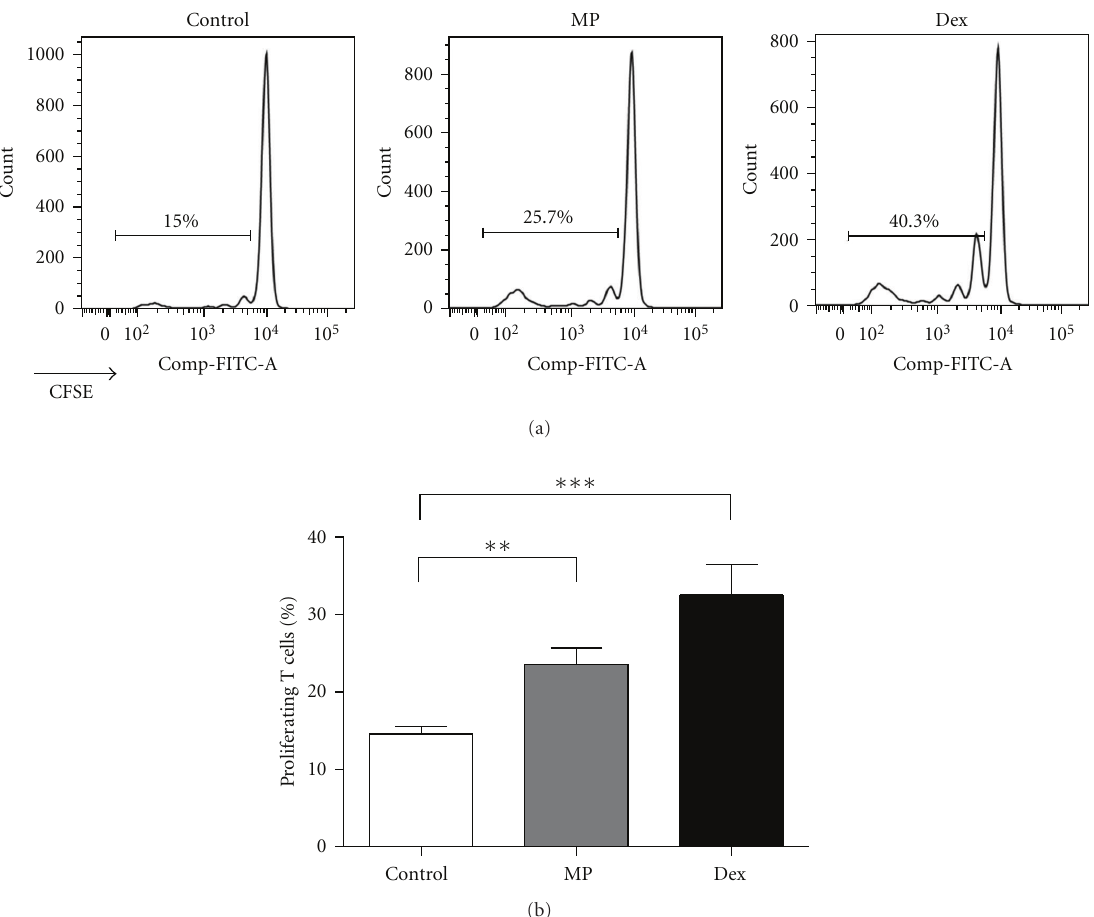
Figure 4: Homeostatic proliferation of transferred T cells after MP administration. C57Bl/6 mice were immunized with MOG 35-55 peptide and treated with 100 mg/kg MP, 100 mg/kg Dex, or PBS as a control on days − 1, 0, and 1. One day after the last treatment, 1 × 10 7 purified CFSE-labeled T cells from RFP expressing mice were adoptively transferred, and ten days later, spleens and lymph nodes were analyzed by flow cytometry. (a) Representative histograms of lymph node total RFP + T cells from PBS-(left), MP-(middle) or Dex-(right) treated mice are shown. (b) A quantification of the percentages of proliferating transferred T cells in the inguinal lymph nodes is depicted. n = 3-8 for each group. Statistical analysis was performed using the unpaired t -test ( ∗∗ P < 0 . 01, ∗∗∗ P < 0 .